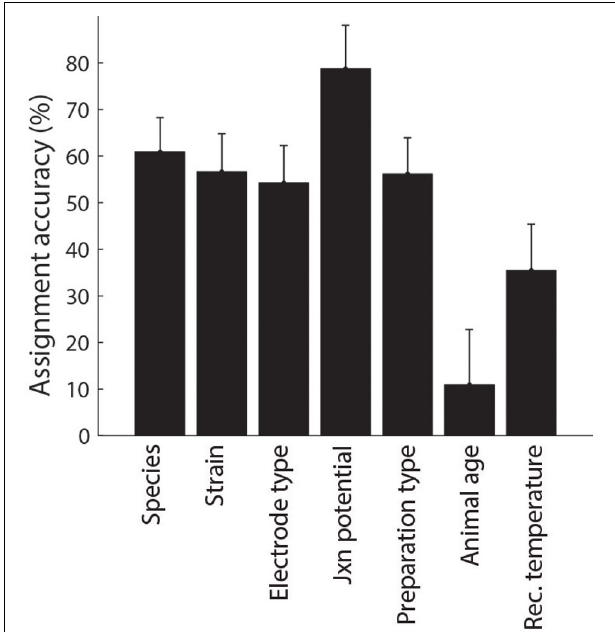
FIGURE 5 | Accuracy of metadata assignment using automated methods alone. Error indicate 95% binomial confidence intervals.